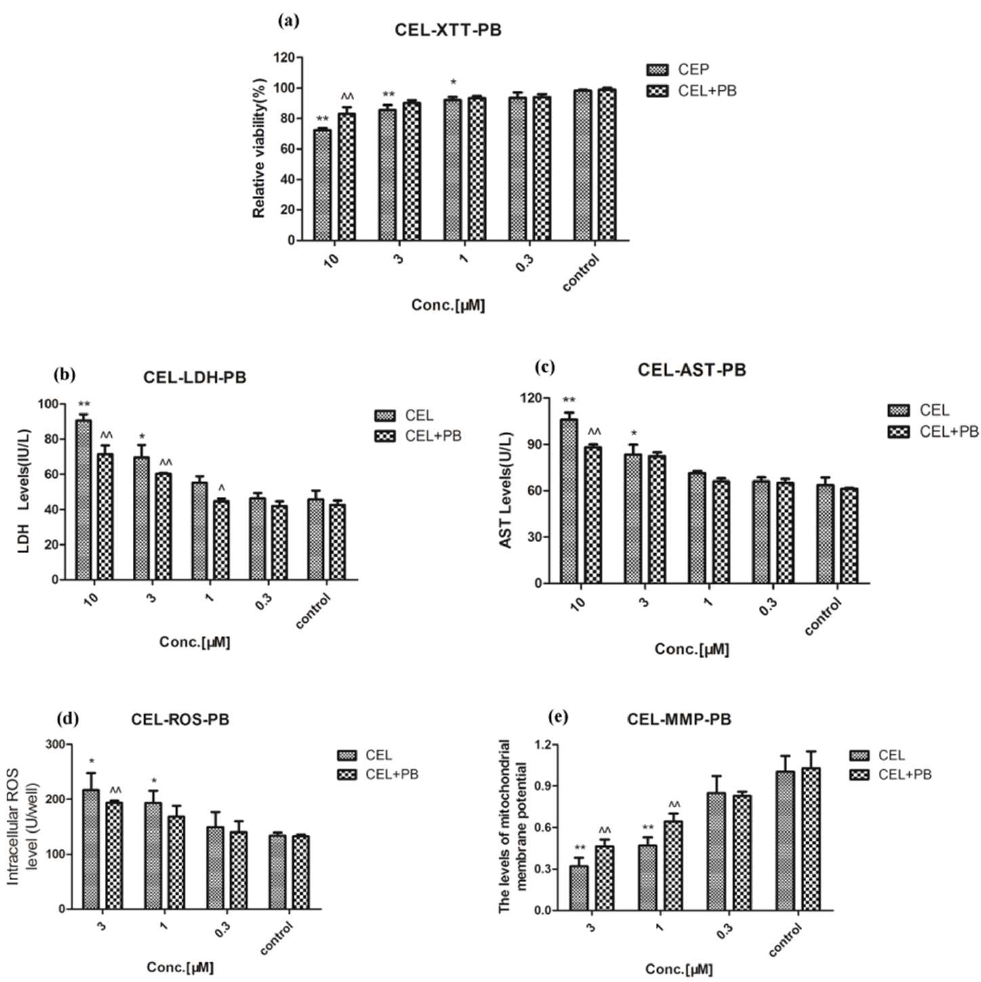
Figure 6. The influence of celastrol on cells after PB was treated at the concentration of 40 mg/kg for five days. ( A ) The relative viability after treatment with a variety of concentrations of celastrol. ( B ), ( C ), ( D ) LDH, AST, and ROS in cellular supernate accumulation in treatment with primary rat hepatocytes, respectively. ( E ) The MMP after exposure to different concentrations of celastrol. Compared with the control group, * p < 0.05, and ** p < 0.01; compared with celastrol group, ^ p < 0.05, and ^^ p < 0.01.